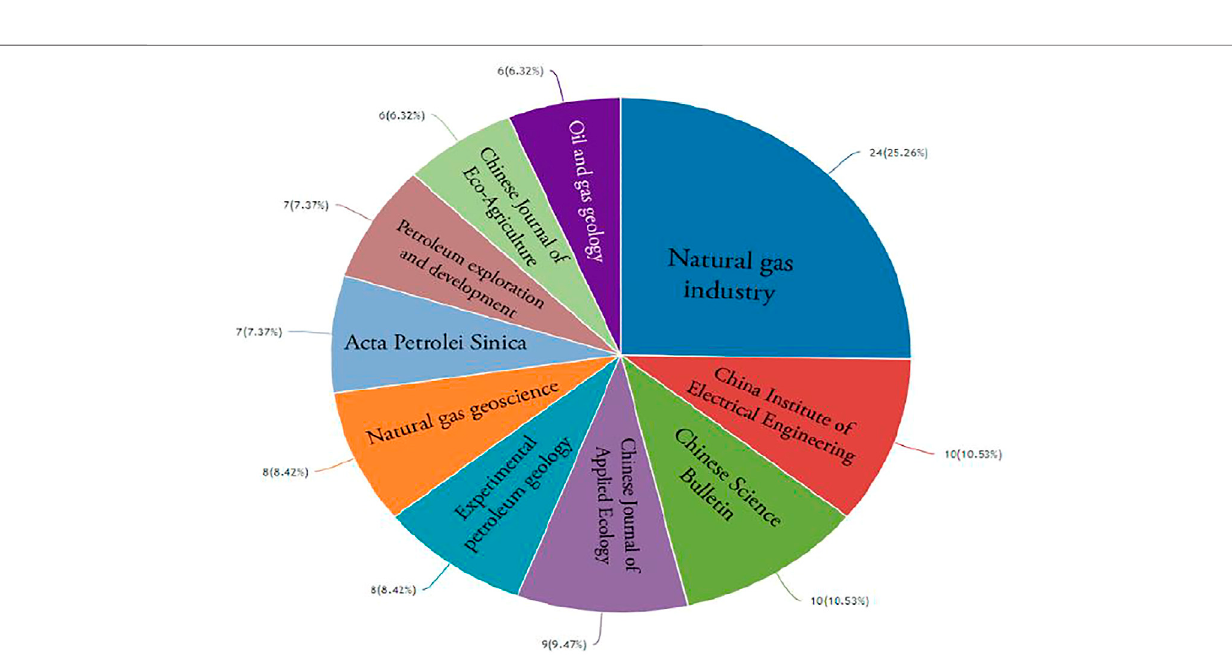
FIGURE 3 | Proportion of major source